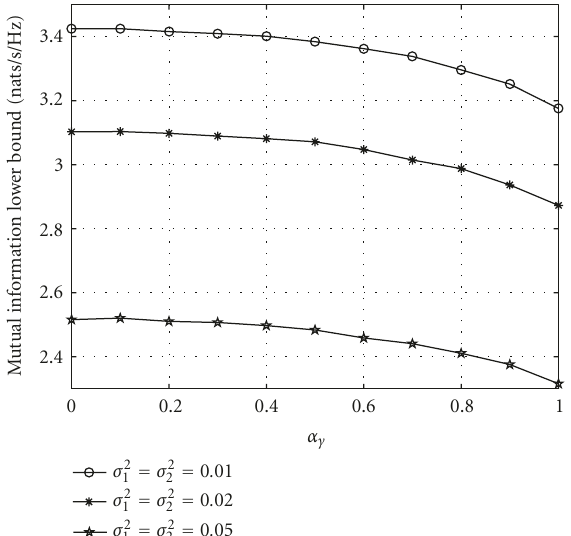
Figure 4: Mutual information lower bounds for D-STBCs with single receive antenna at SNR = 15dB, given γ 1 = 1 + α γ and γ 2 = 1 − α γ .